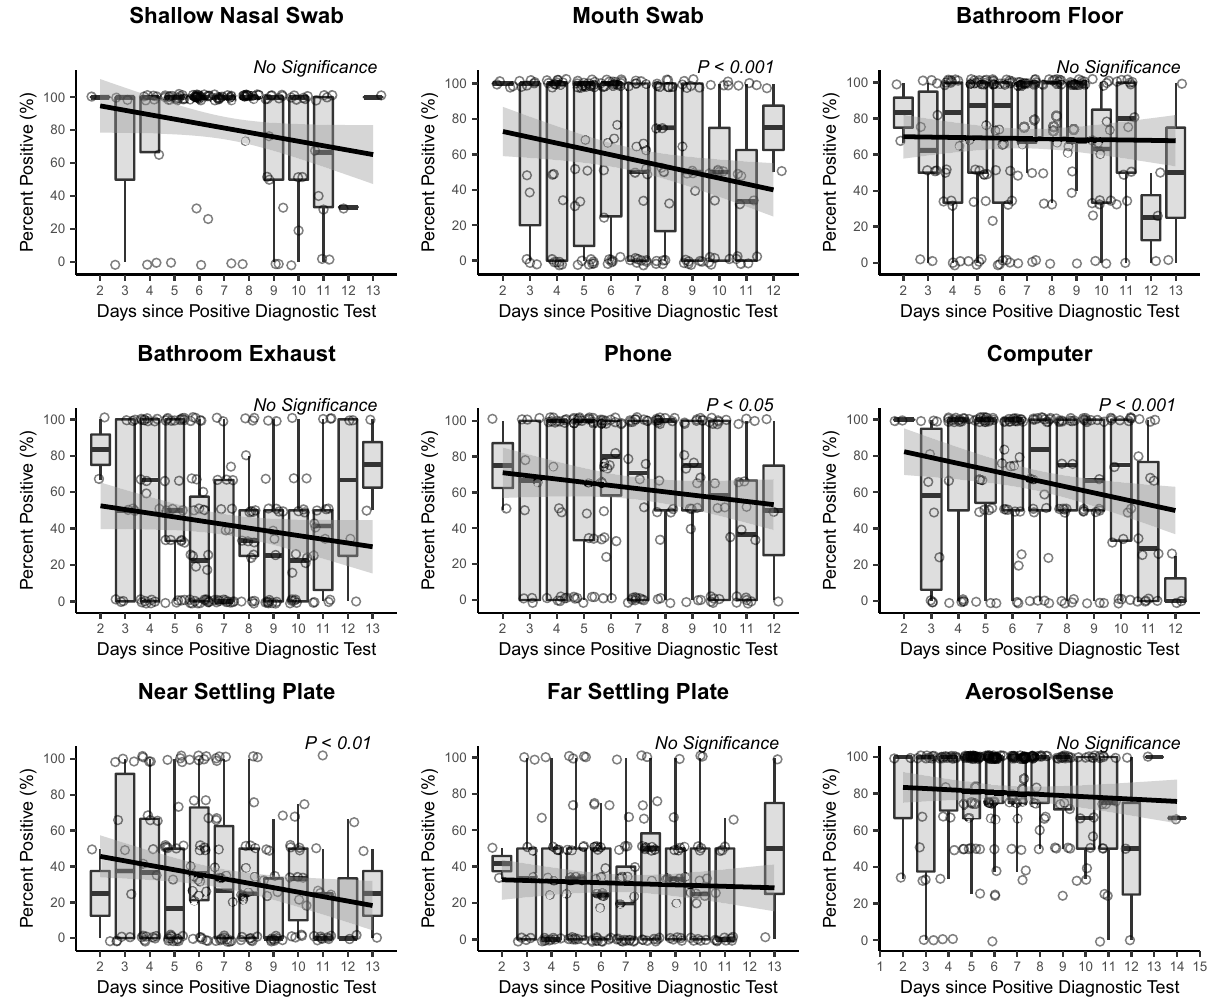
Figure 2. Mean daily percent positivity at each sampling location. The percent positivity rate per entry per study subject was calculated and the mean positivity rate of all participants per day enrolled in the study was calculated as the daily percentage rate. The black line represents a linear mixed model estimated using a restricted maximum likelihood (REML) approach and including the individual occupying the room as a random effect and the grey area represents the 95% confidence interval for that